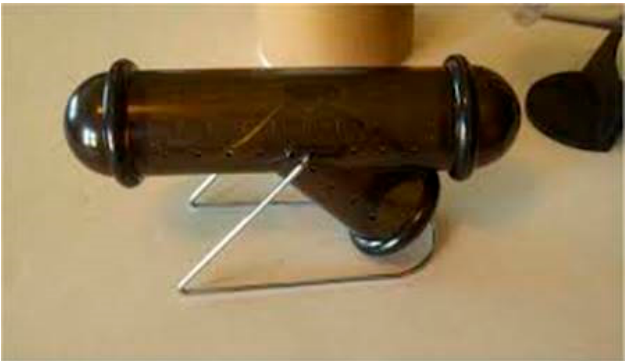
Figure A1. Mouse trap #1.